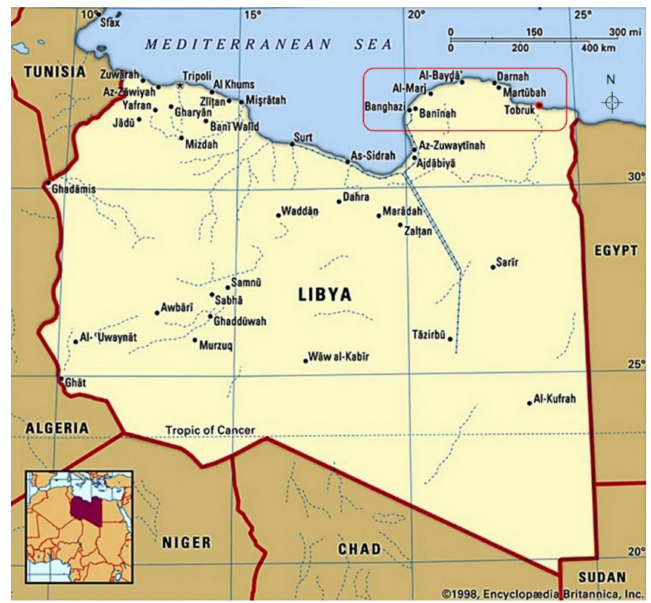
Figure 1. A map shows the location of Tobruk city and the neighboring cities (within the red blank). Reprinted with permission from ref. [9]. Copyright 2022, Encyclopædia Britannica.